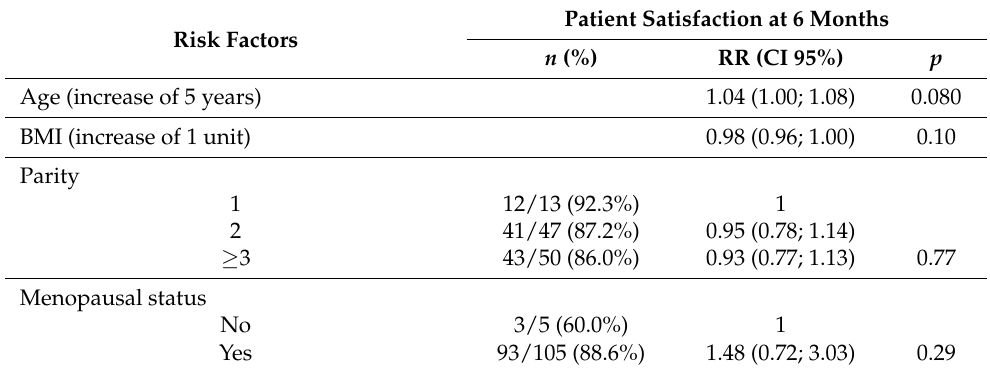
Table 4. Factors associated with patient satisfaction at 6 months (using log-binomial